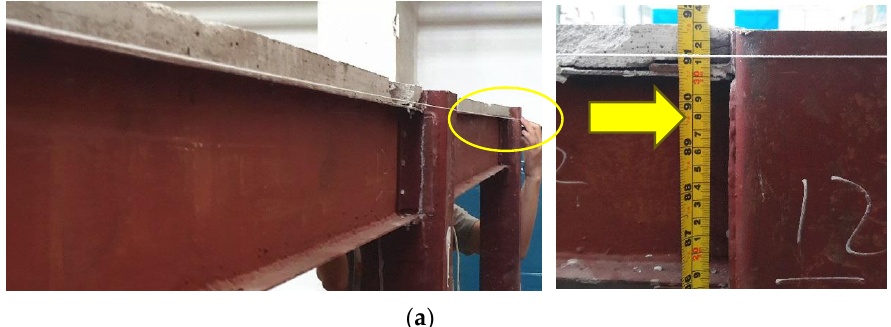
Figure 11. Photo of the impacted column after case G6. ( a ) Model A; and ( b ) Model B.